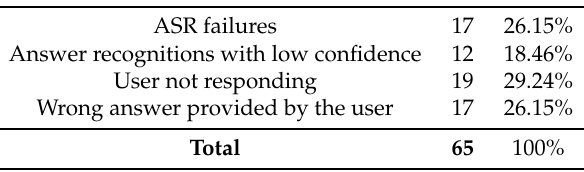
Table 4. Usage of the recovery